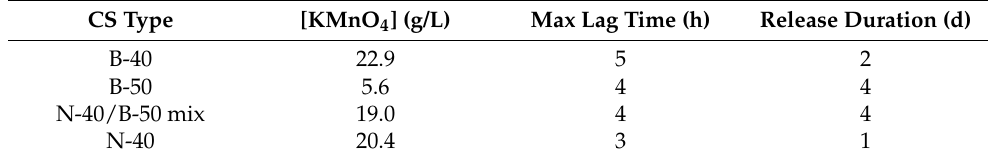
Table 2. Maximum gelation lag times and corresponding release durations for each type of